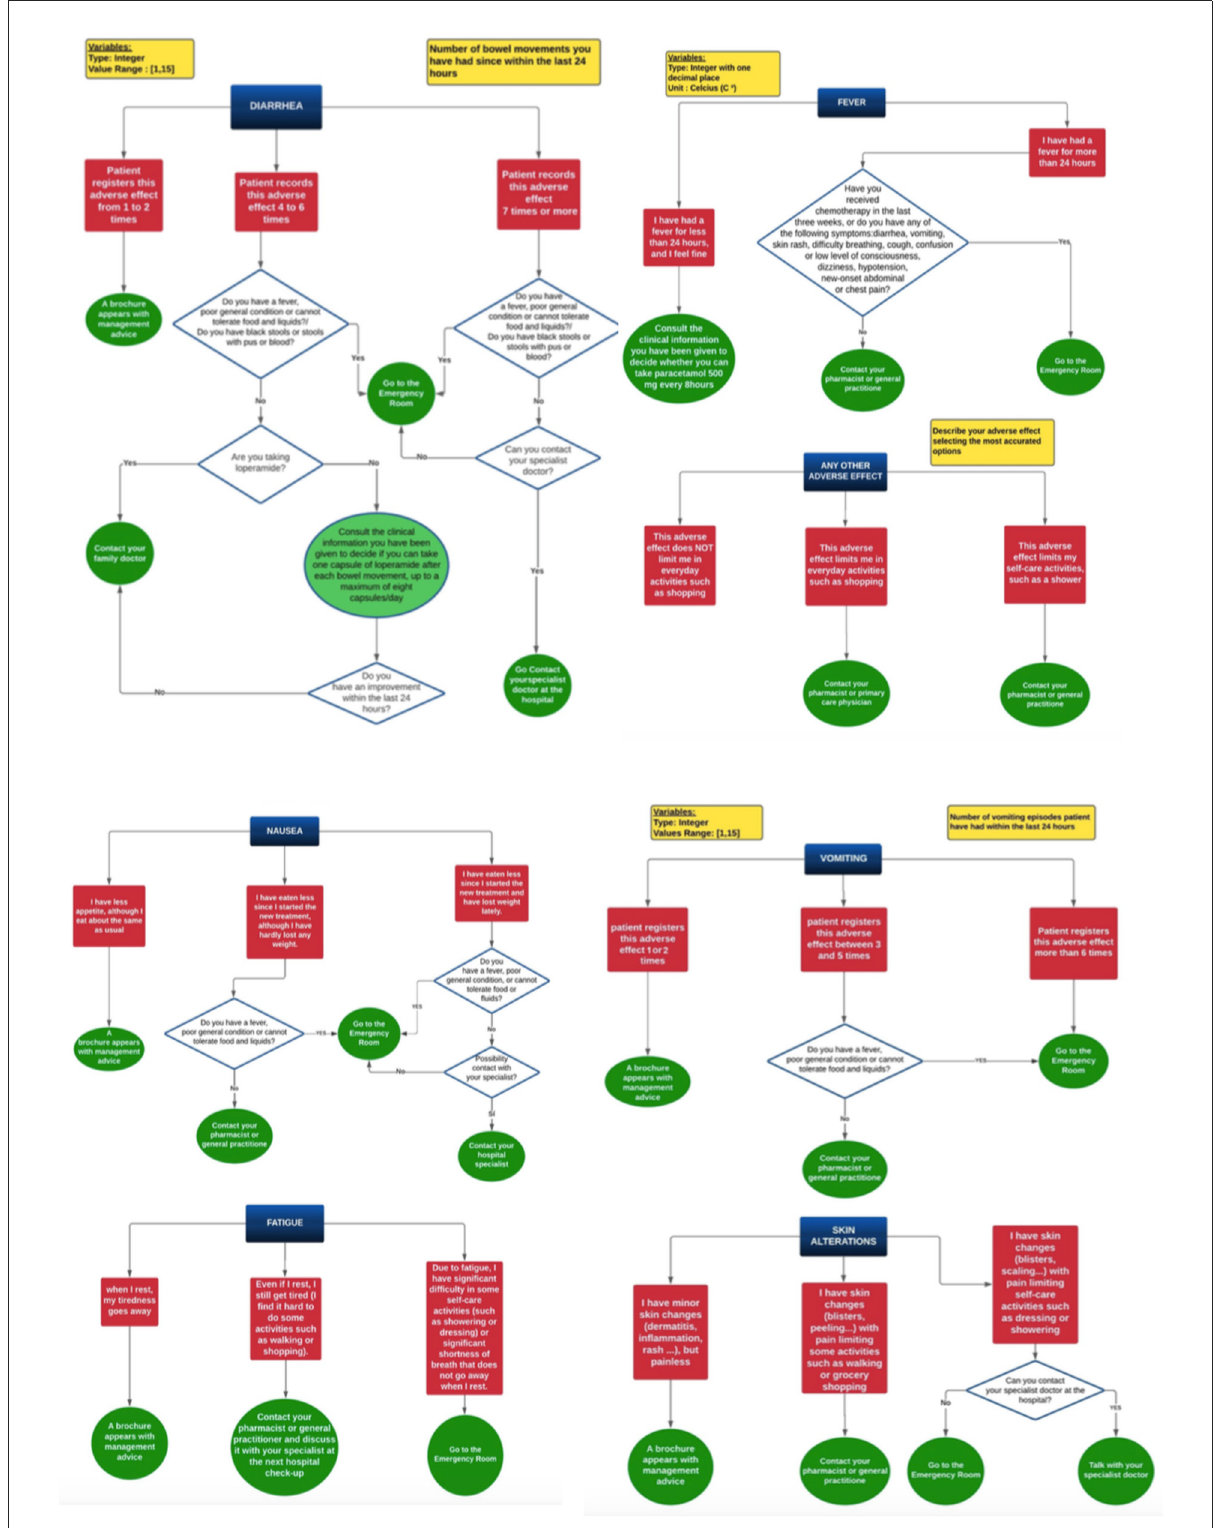
FIGURE2 Algorithm to classify the AE by severity according to the